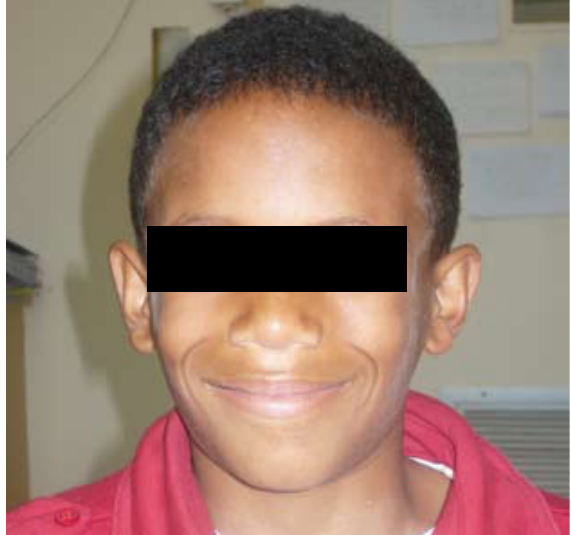
Fig. 4. Moderate LA of the face, front view. Note the loss of the buccal fat pad, resulting in lean, muscular appearance of the face with deep laugh-lines.